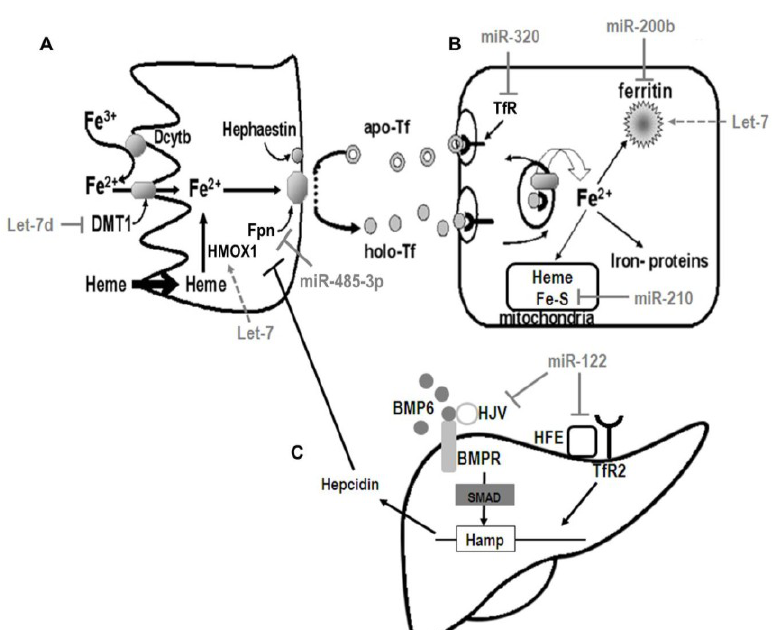
Figure 2. The potential roles for miRNA to influence iron metabolism. ( A ) Dietary iron absorption. Non-heme (Fe 3+ ) iron may be reduced by duodenal cytochrome B (Dcytb) and transported into the cytosol by divalent metal transporter-1 (Dmt1). Dietary heme iron is transported across the apical membrane by mechanisms that remain unclear and iron is released from heme by heme oxygenase (Hmox1). Hmox1 expression is de-repressed via miR-let-7 targeting the transcriptional repressor Bach1. Iron that is neither stored nor utilized by the enterocyte is exported across the basolateral membrane by ferroportin-1 (Fpn) where it is oxidized by hephaestin before being bound to transferrin for transport to other tissues. Fpn-mediated iron export can be repressed through direct inhibition of Fpn by miR-485-3p. ( B ) Cellular iron uptake. The transferrin-bound iron binds to the transferrin receptor (TfR) on the plasma membrane. The Tf/TfR complex is internalized through receptor-mediated endocytosis and upon acidification of the endosome iron is released from Tf. The Tf/TfR complex can then be recycled back to the plasma membrane where the complex dissociates at a neutral pH. MiR-320 contributes to the regulation of cellular iron uptake by repressing TfR translation to decrease transferrin-dependent iron uptake. Endosomal iron released from Tf is carried into the cytoplasm by Dmt1, the expression of which may be repressed by miR-let-7d. The iron is then either stored in ferritin or utilized for iron-containing proteins. The regulatory action of miR-let-7 on Bach1 to de-repress ferritin transcription potentially enhances cytosolic iron storage. Utilization of iron is influenced directly by miR-210 which targets the Fe–S cluster assembly proteins Iscu1/2 thereby decreasing mitochondrial metabolism. ( C ) Systemic control of iron homeostasis. In the liver, Tf interacts with TfR2 and the protein Hfe to trigger the bone morphogenetic protein (BMP) and SMAD signaling cascade via interaction with the BMP co-receptor hemojuvelin (Hjv) to activate Hamp (hepcidin) transcription. The liver specific miR-122 directly targets HFE and HJV to contribute to the regulation of systemic iron homeostasis by decreasing hepcidin mRNA